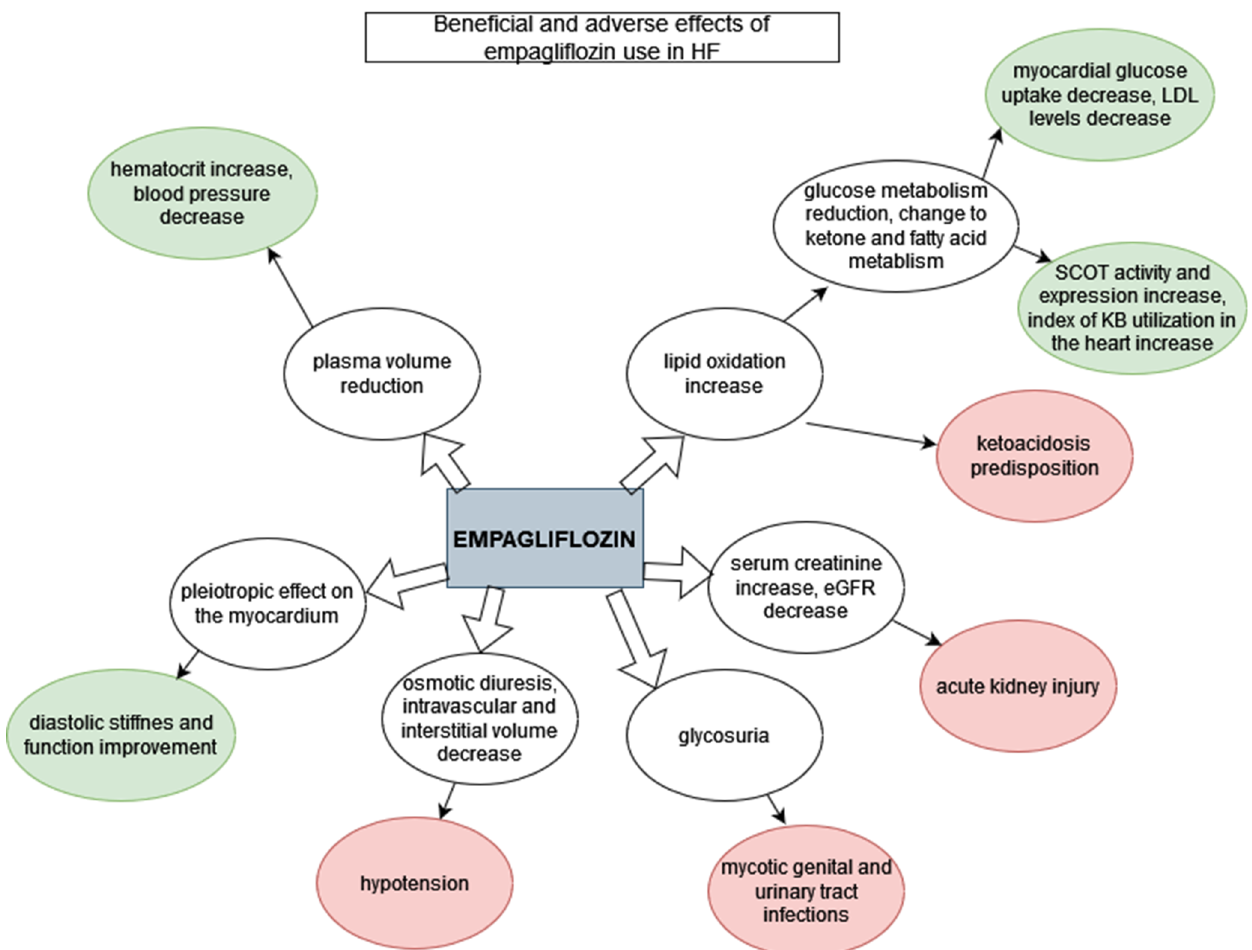
Figure 2. Beneficial and adverse effects of empagliflozin use in HF. Green: beneficial effects; red: adverse effects.